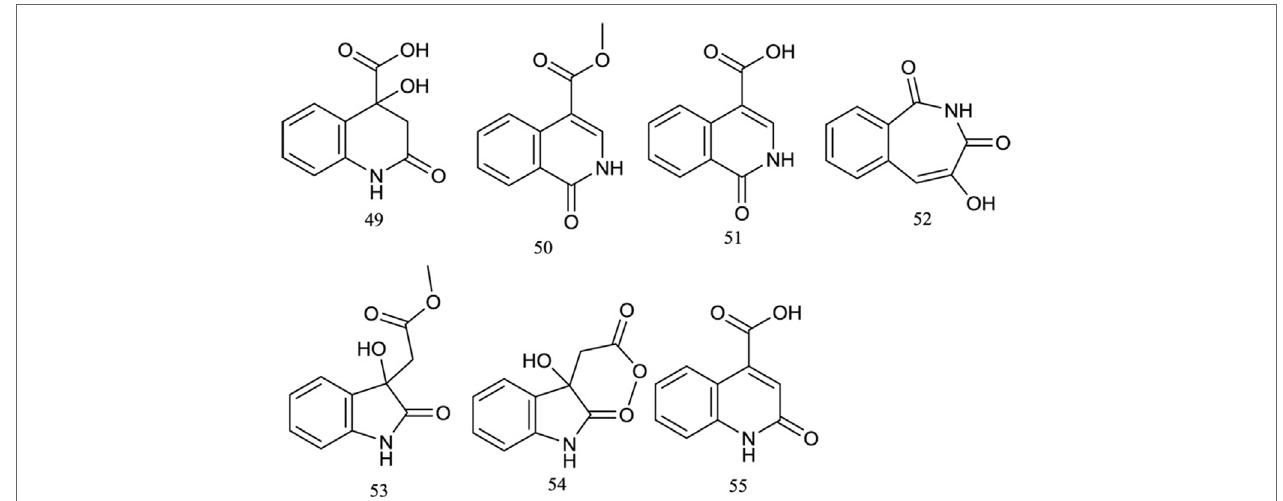
FIGURE 4 | Chemical structures of alkaloids (49–55) isolated from R. chingii